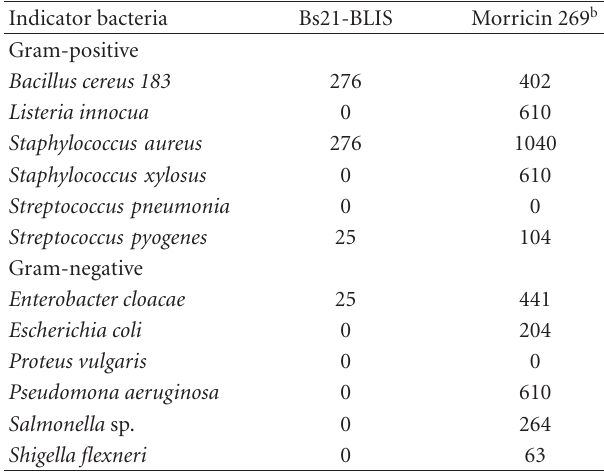
Table 3: Antibacterial activity ( U a ) of partial purified bacteriocins from B. subtilis 21